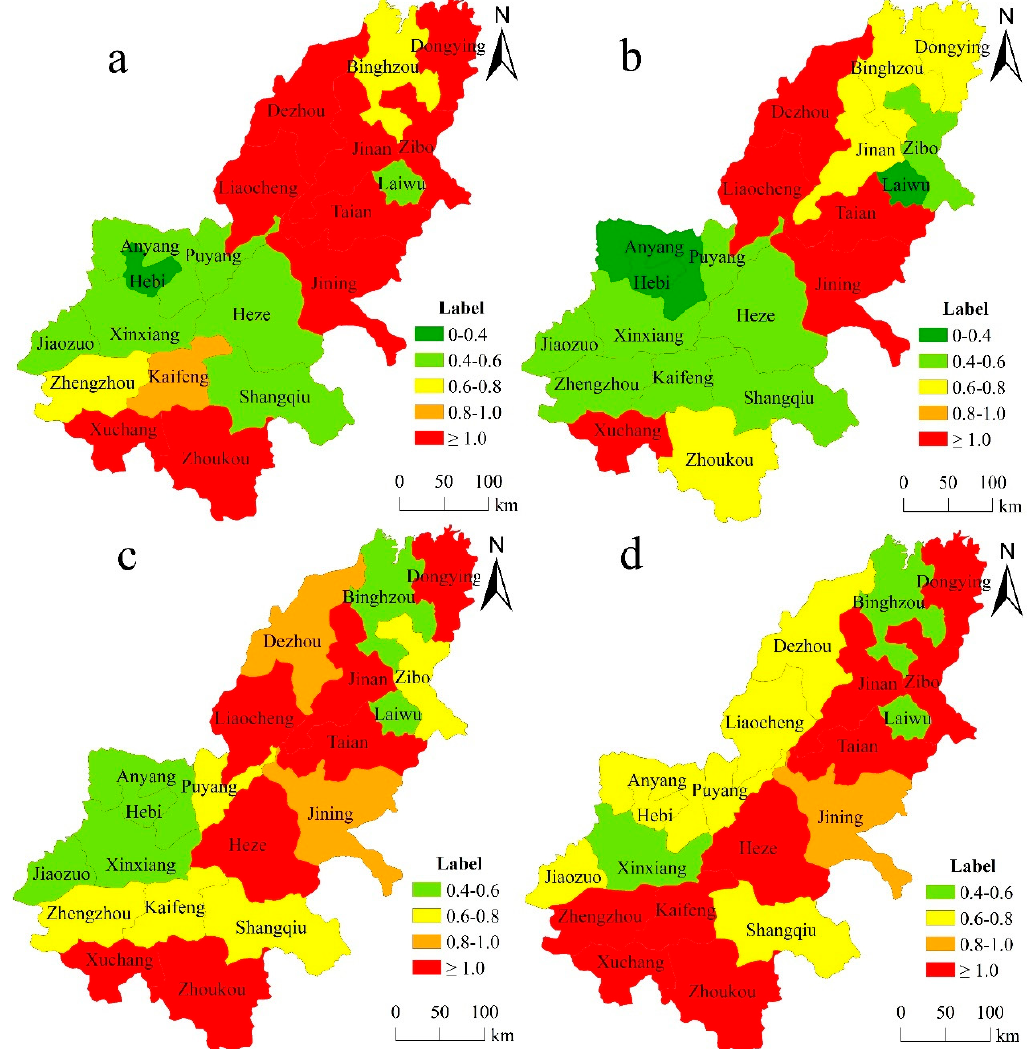
Figure 4. Spatial distribution pattern of the urban eco-efficiency in the lower reaches of the Yellow River (( a ) 2007; ( b ) 2011; ( c ) 2015; ( d ) 2018).